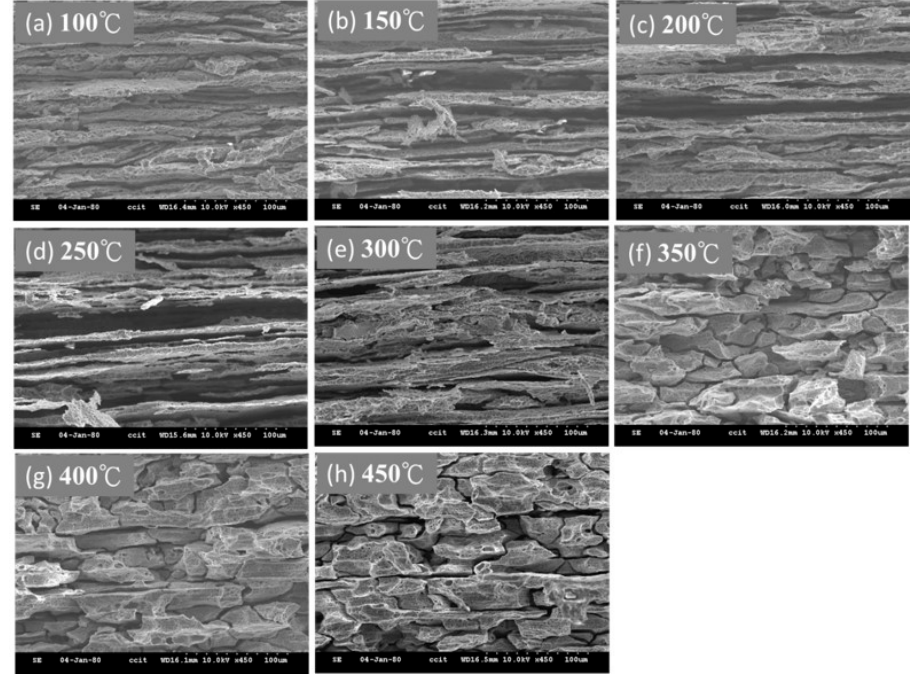
Figure 7. SEM images of corrosion in 5383-H116 after different heat treatment conditions and sensitization treatment. ( a ) 25 °C; ( b ) 100 °C; ( c ) 150 °C; ( d ) 200 °C; ( e ) 250 °C; ( f ) 300 °C; ( g ) 350 °C; ( h ) 400 °C; ( i ) 450 °C.